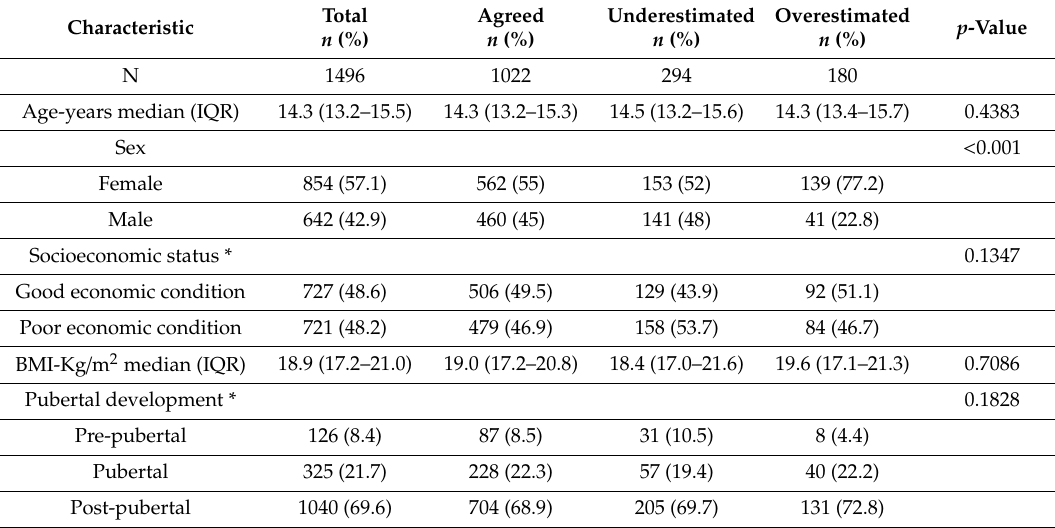
Table 1. Characteristics of the study participants.